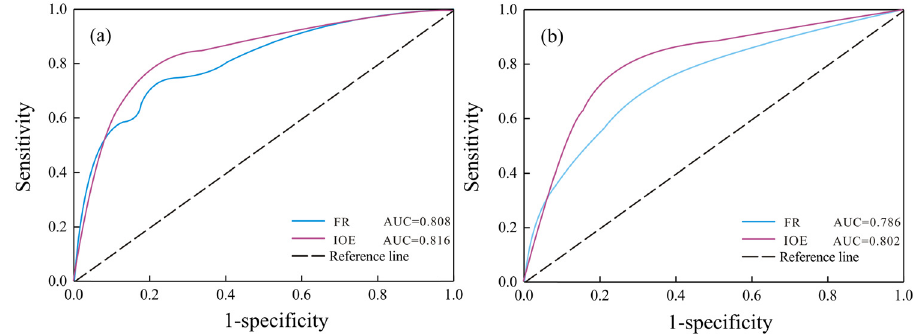
Figure 7: Success and prediction rate curves for the LSMs produced in this study. ( a ) Success; ( b )